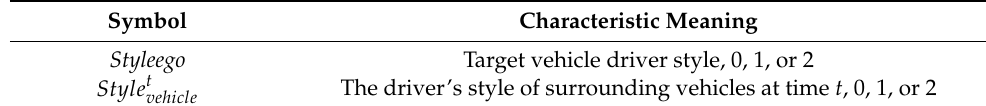
Figure 13. The relative position of vehicles. Table 7. Lane-changing intention recognition